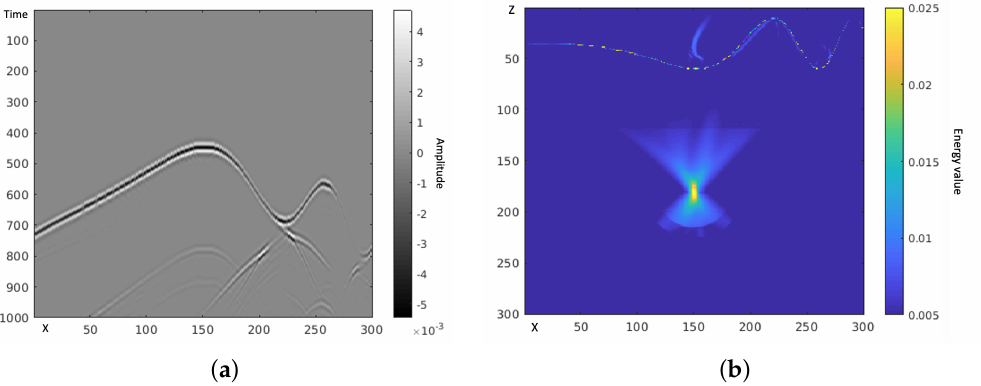
Figure 17. ( a ) The record of the observed seismic data; ( b ) the localization